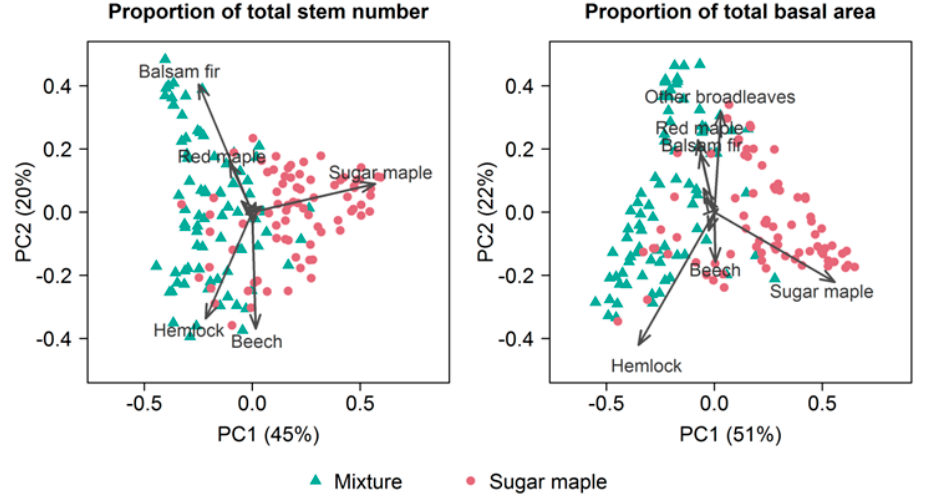
Figure 2. Separation of calibration plots according to an ecosite classification defined from aerial imagery. The biplot shows the first two axes of a Principal Components Analysis (PCA), and the percentage of variation explained by each axis (in parentheses). The PCA was performed on the main species in each calibration plot as a proportion of ( a ) the total stem number and ( b ) the total basal area; the shape and colour of the points denote the ecosite classification for these plots.